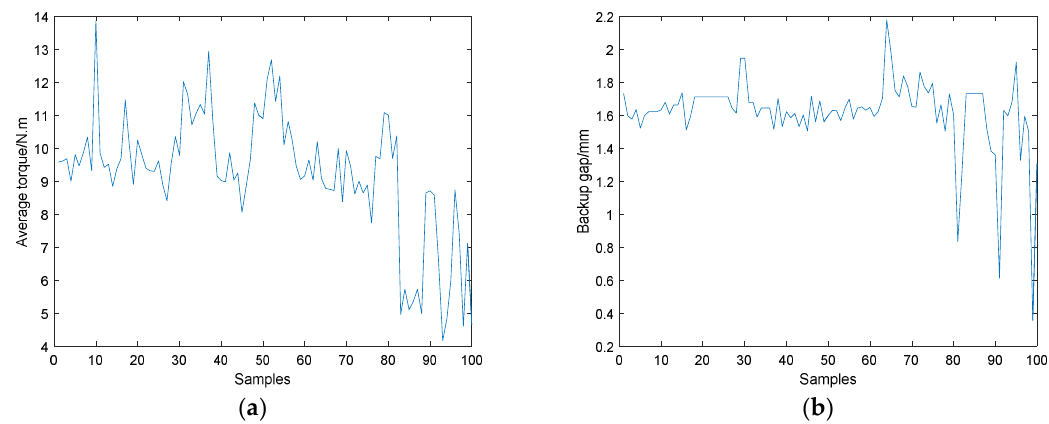
Figure 13. Measured results of the 100 sets of workpieces. ( a ) average torque; ( b ) backup gap.